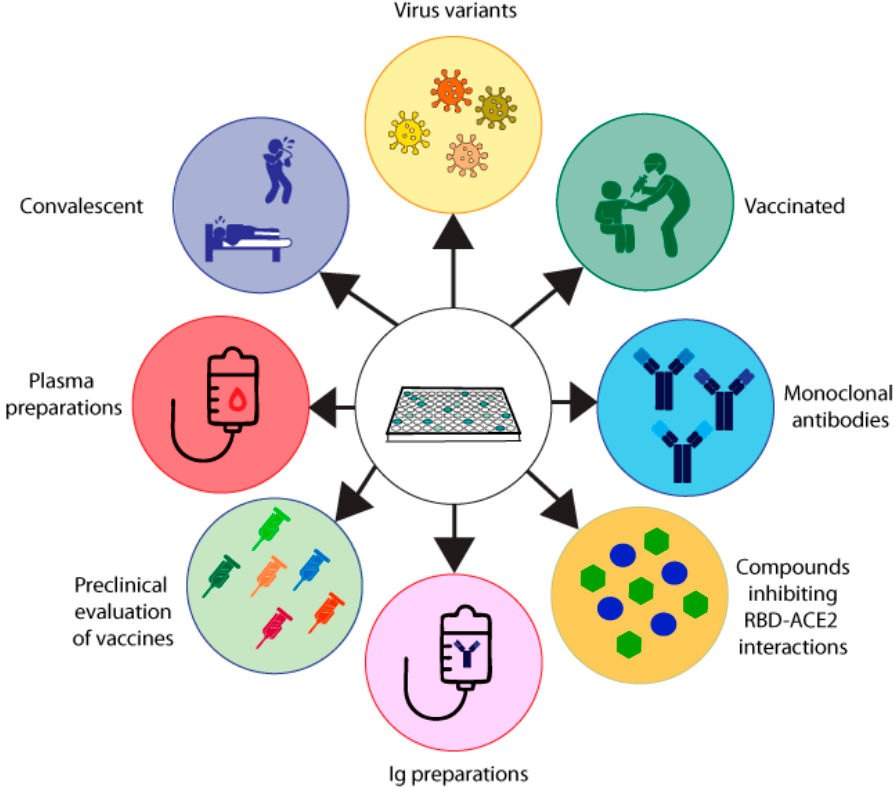
Figure 3. Overview of areas of application for molecular assays. Results from molecular assays mimicking SARS-CoV-2 infections can be used to determine protective antibodies of convalescent and/or vaccinated subjects or populations, as well as their blocking efficacy for emerging variants of concern. Plasma preparations and monoclonal antibodies used for preventive treatment can be tested for their neutralizing capacity.